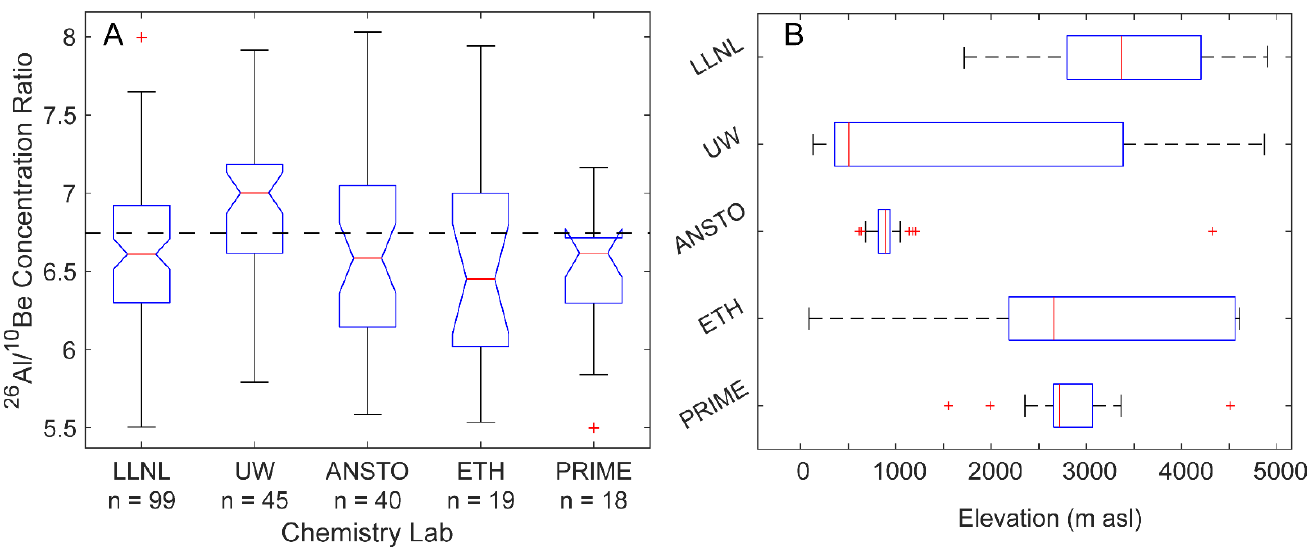
Figure 7. ( A ) ANOVA boxplots for sample preparation labs, see Figure 5 for explanation. Note that the PRIME box appears distorted because the upper limit of the median comparison interval exceeds the 75th percentile value. ( B ) Elevations of samples processed by five different sample preparation laboratories.